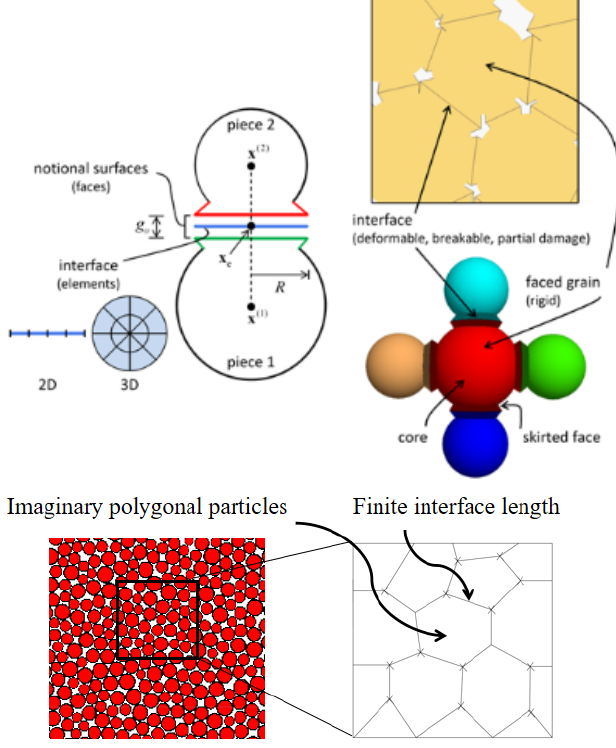
Figure 1. Flat-joint contact Figure 1. flat-joint contact mode.